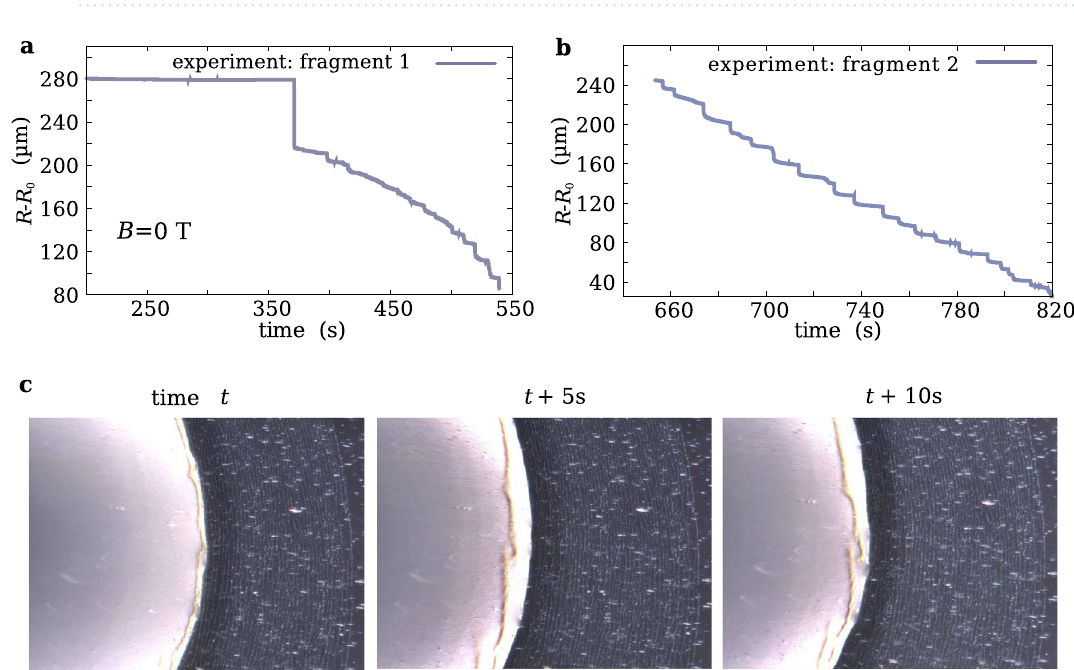
Figure 5. Evolution over time of a drying droplet. ( a ) The plot of the droplet radius R vs. time data obtained with the help of the optical microscope measurements along the stretching direction of the LDPE film (no magnetic field, B = 0 T). The R 0 point is the reference point under the microscope camera objective against R 0 distance was measured. ( b ) Continuation of the measurement ( a ) from another reference which the R − point R 0 after the microscope camera reached the edge of the measurement window. ( c ) The frames from a movie under an optical microscope, where the fragments of the nanoparticle ring-shaped deposits float. The droplet dries in the presence of a magnet placed 5.2 mm below the LDPE